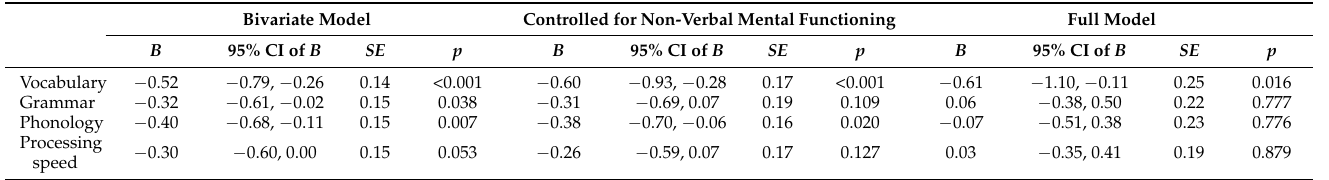
Table 3. Regression analyses of association with difficulties with fluency among children with Down syndrome ( N =